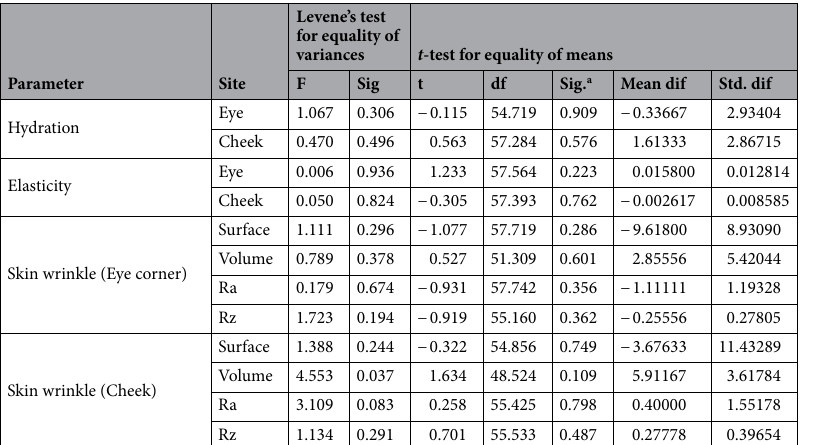
Table 4. Statistical evaluation between test and placebo groups prior to clinical trial. a p > 0.05 indicating non- significant differences between test and placebo groups at baseline evaluated by independent t -test. Mean dif. : Mean difference; Std. dif. : Standard error difference.